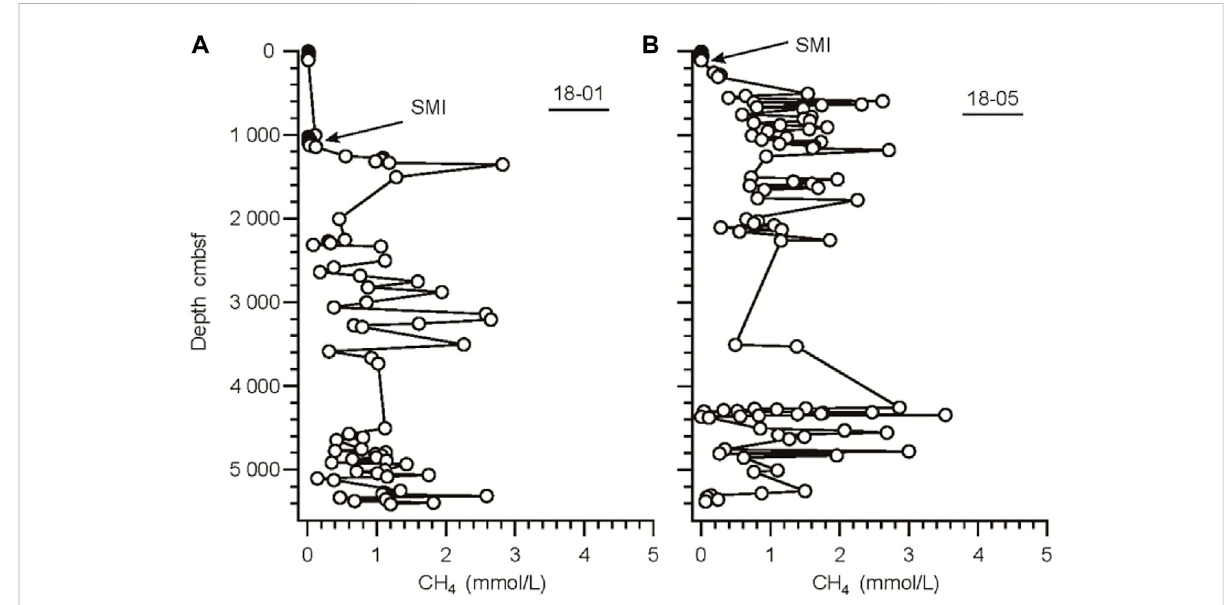
FIGURE 3 Depth pro fi les of headspace methane concentration in pore water of 18-01 (A) and (B) 18-05